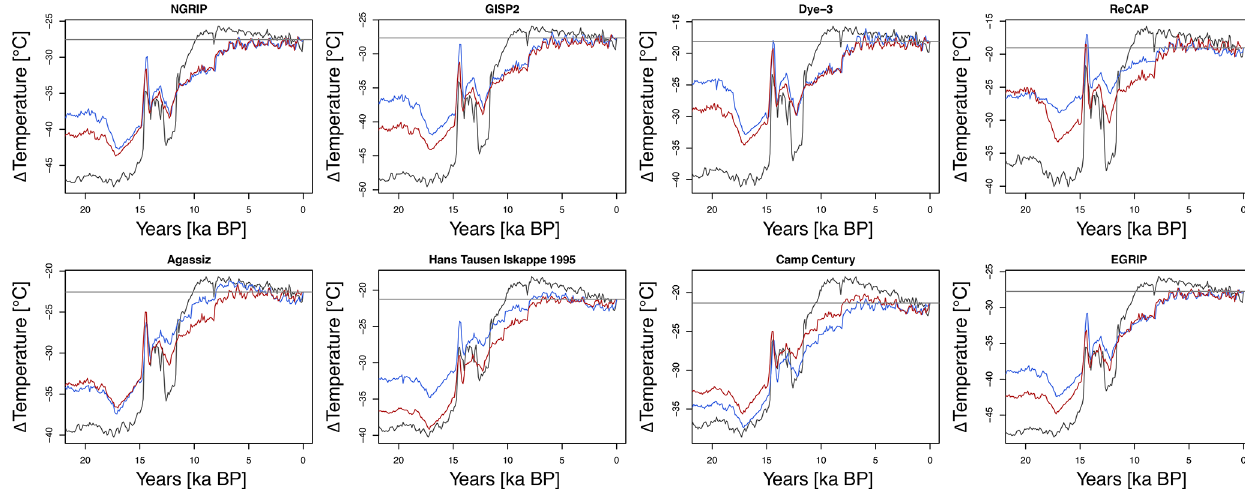
Figure 5. Comparison of temperature anomalies from current times (1950–1990) for the CHELSA-TraCE21k time series data (blue), the TraCE21k data (red), and the temperature reconstructions from ice cores (black) for eight sites across Greenland. The gray horizontal line indicates the current observed temperature during the period 1981–2010 from CHELSA V2.1. data. Temperatures are plotted as anomalies from the current temperature recorded at the respective location of the ice